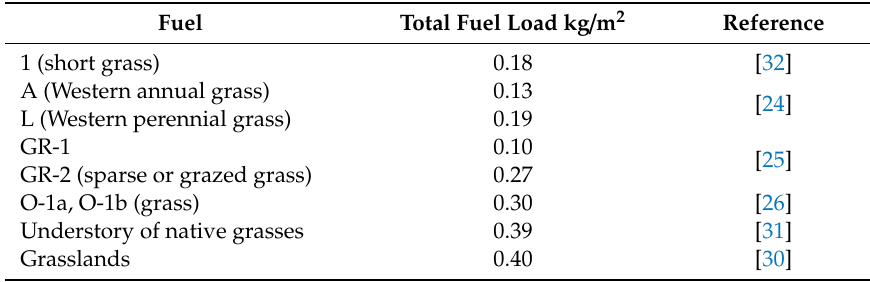
Table 1. Fuels chosen for extensive green roofs.